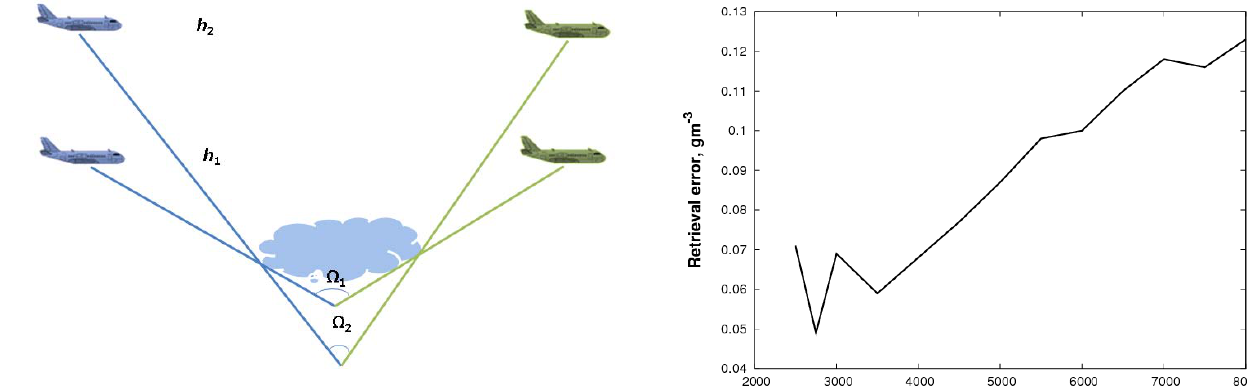
Figure 11. Illustration of the dependence of radiometer viewing angle on the aircraft Fig. 11. Illustration of the dependence of radiometer viewing angle altitude. The range of radiometer viewing angles (indicated as Ω 1 , Ω 2 ) decreases with the on the aircraft altitude. The range of radiometer viewing angles vertical distance between the aircraft and the cloud. (indicated as (cid:127) 1 , (cid:127) 2 ) decreases with the vertical distance between the aircraft and the cloud.